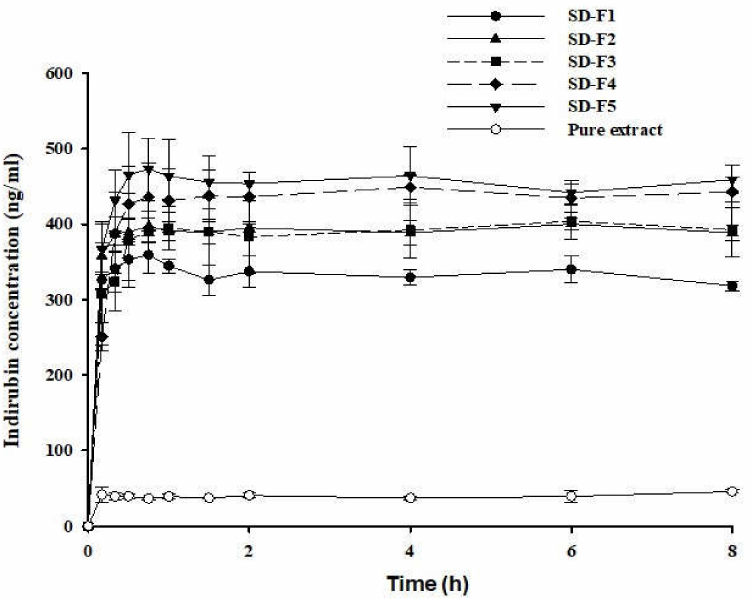
Figure 4. Dissolution profiles of indirubin from various SD formulations and pure extract (pure MT-102) in water (mean ± s.d., n =